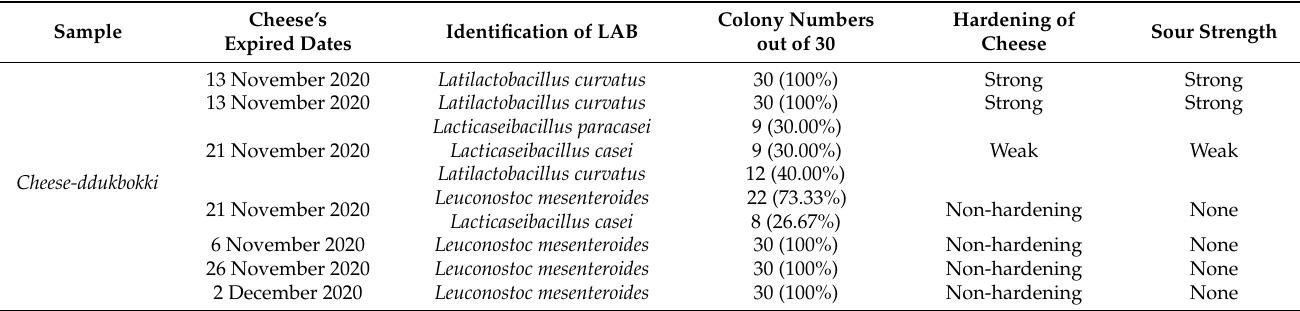
Table 1. Hardening properties and Identification of LAB from cheese- ddukbokki rice cake samples with different manufactur- ing dates. Sample